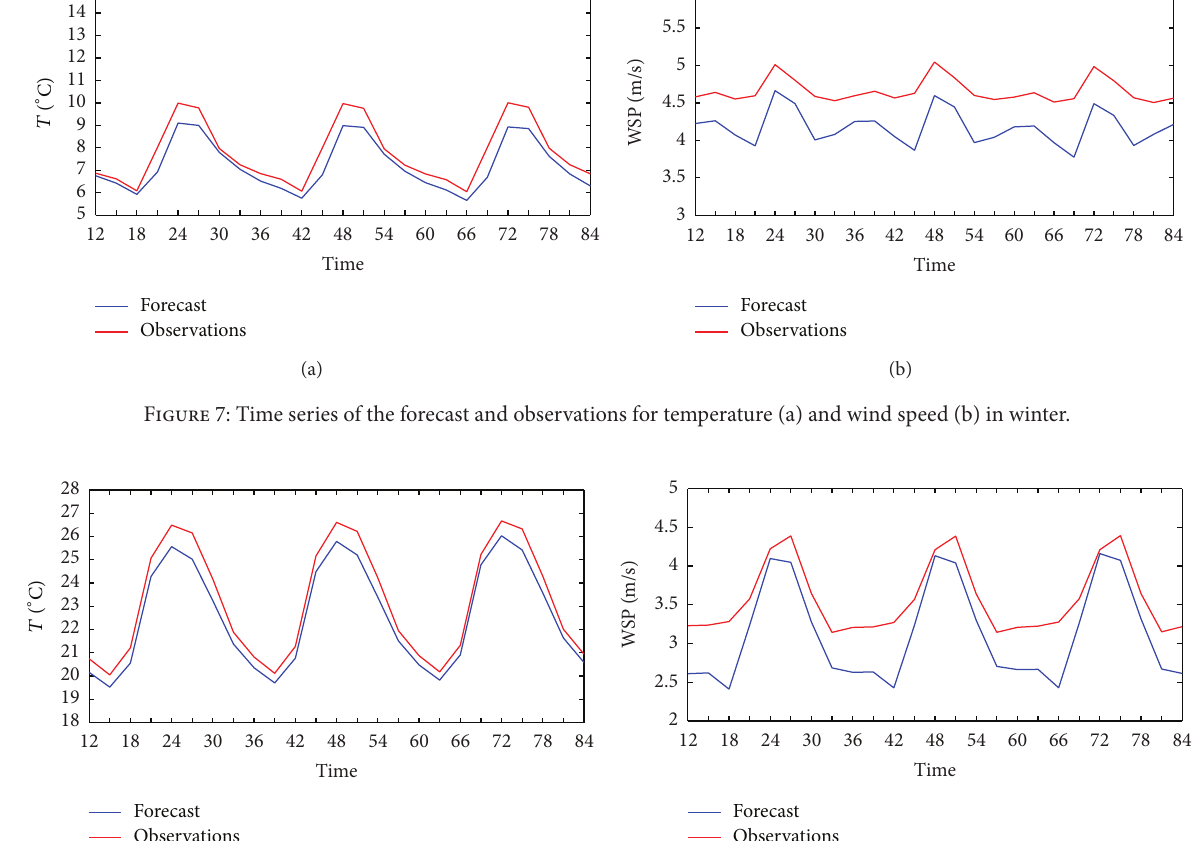
direction in winter, so the errors for wind directions are larger in summer than in